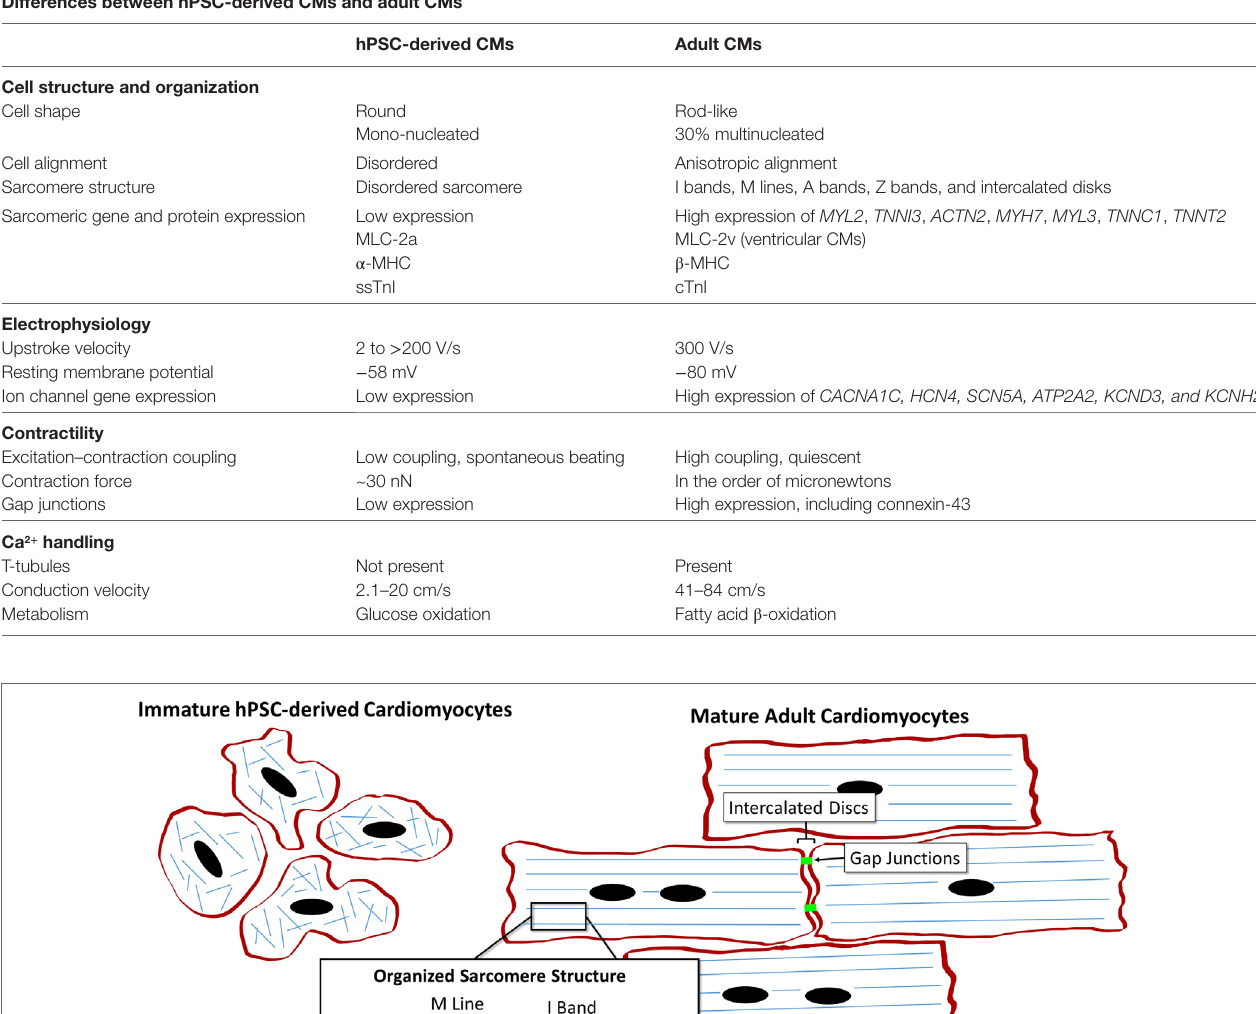
TAbLe 1 | Comparison of human pluripotent stem cell (hPSC)-derived cardiomyocytes (CMs) and adult CMs to demonstrate the changes during maturation. Differences between hPSC-derived CMs and adult